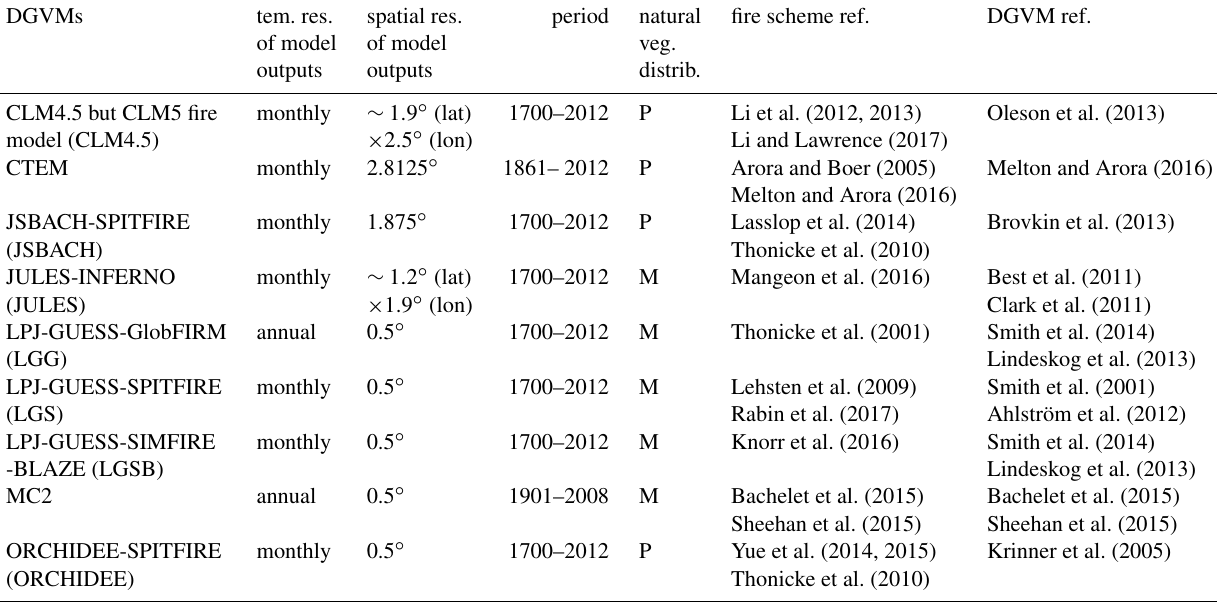
Table 1. Summary description of the dynamic global vegetation models (DGVMs) that participated in FireMIP. DGVMs tem. res. spatial res. period natural fire scheme ref. DGVM ref. of model of model veg. outputs outputs distrib. CLM4.5 but CLM5 fire monthly ∼ 1 . 9 ◦ (lat) 1700–2012 P Li et al. (2012, 2013) Oleson et al. (2013) × 2 . 5 ◦ (lon) Li and Lawrence (2017) 2.8125 ◦ 1861– 2012 P Arora and Boer (2005) Melton and Arora (2016) Melton and Arora (2016)